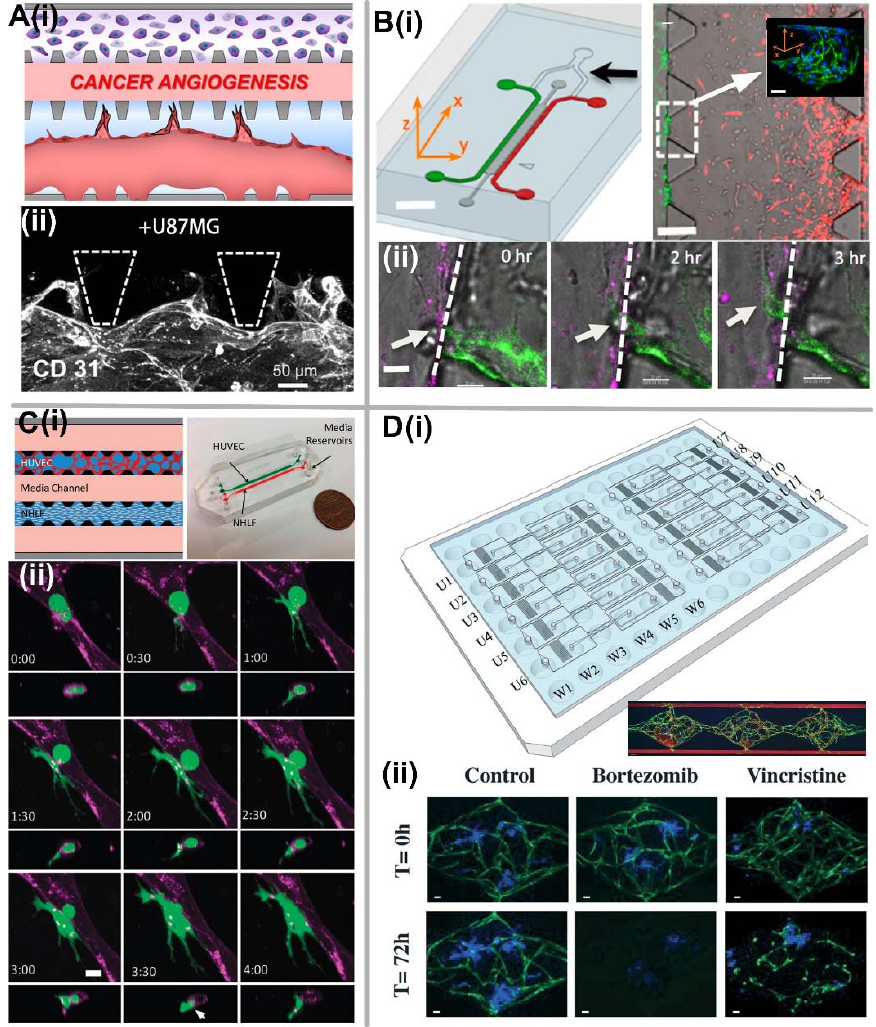
Figure 6. Vascularized tumor-on-a-chip for studying tumor metastasis and anti-cancer drug screening. ( A ) Tumor angiogenesis. ( i ) Schematic of chip design for tumor angiogenesis. ( ii ) 3D confocal image (CD31) shows the angiogenic sprouts stemmed from the microvessel wall grow toward the upper channel stimulated by the pro-angiogenic factors from U87MG cancer cell lines. Adapted by permission from Reference [120], copyright American Institute of Physics 2014. ( B ) Tumor intravasation. ( i ) Schematic of microfluidic tumor-vascular interface model, and the immunostaining image showing confluency of the endothelial monolayer on the 3D ECM. Scale bar, 2 mm (left) or 300 µ m (right). ( ii ) Time sequence of a single confocal slice showing a breast carcinoma cell (white arrow) in the process of intravasaton across a HUVEC monolayer. Scale bar, 30 μ m. Adapted by permission from Reference [124], copyright National Academy of Sciences, USA 2012. ( C ) Tumor extravasation. ( i ) Schematic and prototype of microfluidic device and cell-seeding configuration. ( ii ) Time-lapse confocal images showing the extravasation process of entrapped MDA-MB-231 (green) from vessel lumen (purple). Scale bar, 10 μ m. Adapted by permission from Ref. [126], copyright Royal Society of Chemistry 2013. ( D ) Large-scale anti-cancer drug screening. ( i ) Schematic of microfluidic platform design that custom-fitted into a standard 96-well plate format, and the formation of vascularized microtumor tissue inside three tissue chambers. ( ii ) Drug screening validation with bortezomib and vincristine characterized by the effect on the morphology microvascular network as well as the tumor size. Scale bar, 50 μ m. Adapted by permission from Reference [136], copyright Royal Society of Chemistry 2017.